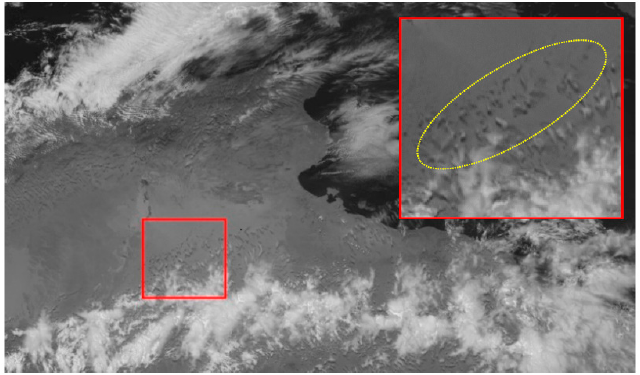
Figure 14. HRV SEVIRI image of 12 May 2010 at 12:00 UTC showing that less reflective clouds and cloud shadows affected the region indicated by the yellow ellipse (within the red box) intersected by the A-B transect of Figure 13a.